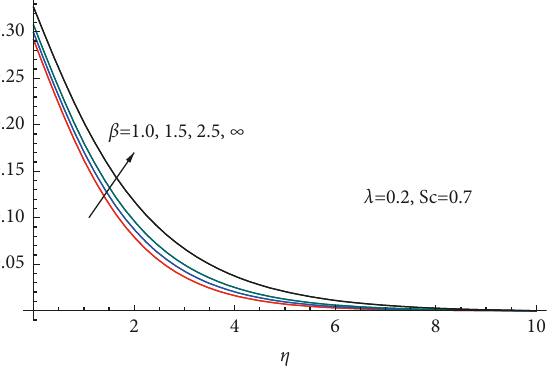
Figure 6: Influence of β on θ ( η ) .